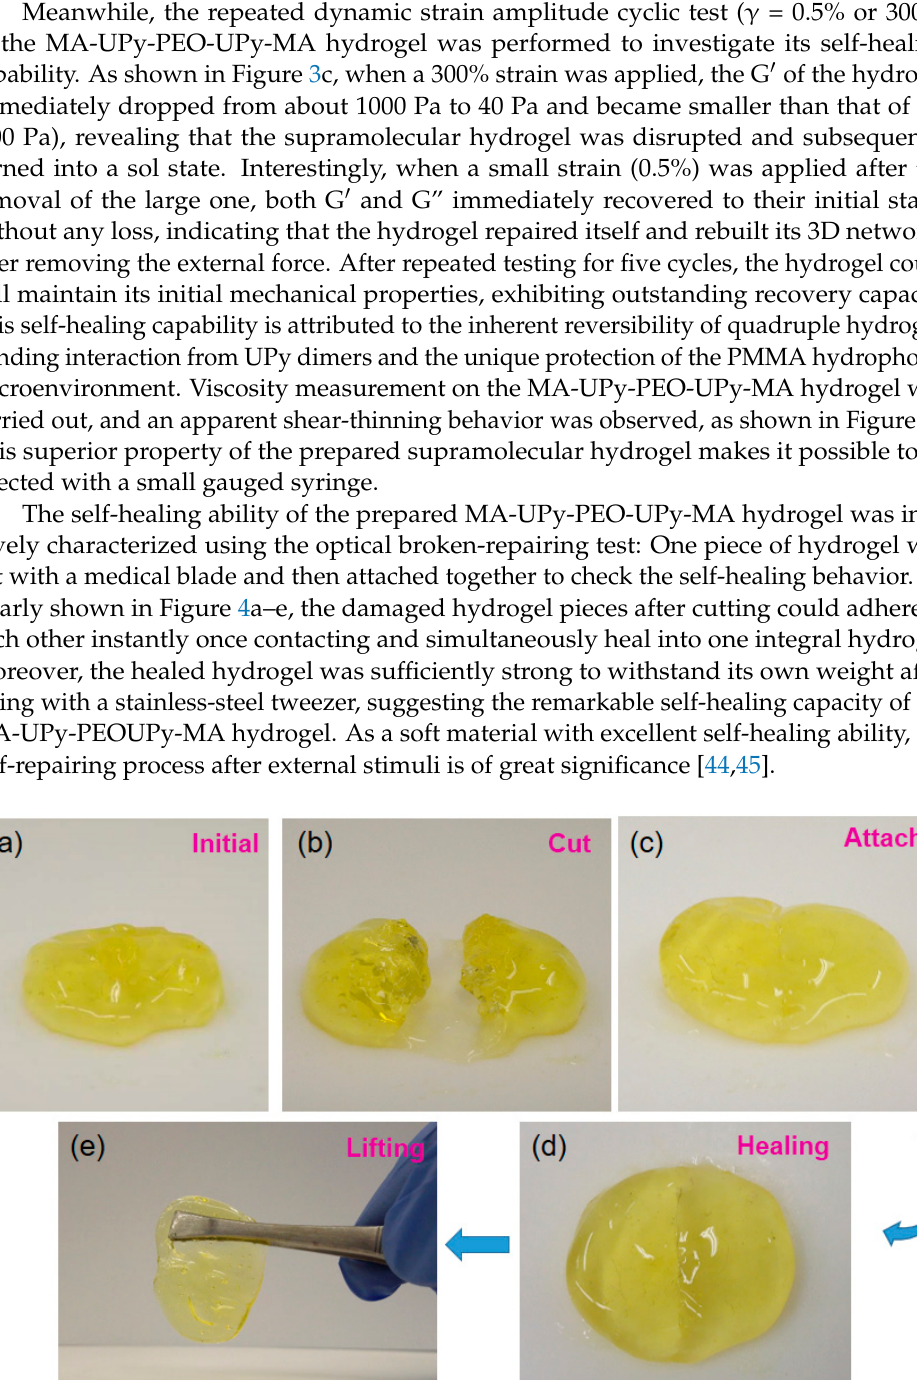
Figure 5. Optical microscope images of the self-healing process of supramolecular hydrogel: ( a ) in- itial hydrogel; ( b ) damaged hydrogel; ( c ) after healing 0.5 h; ( d ) after 5 h healing.